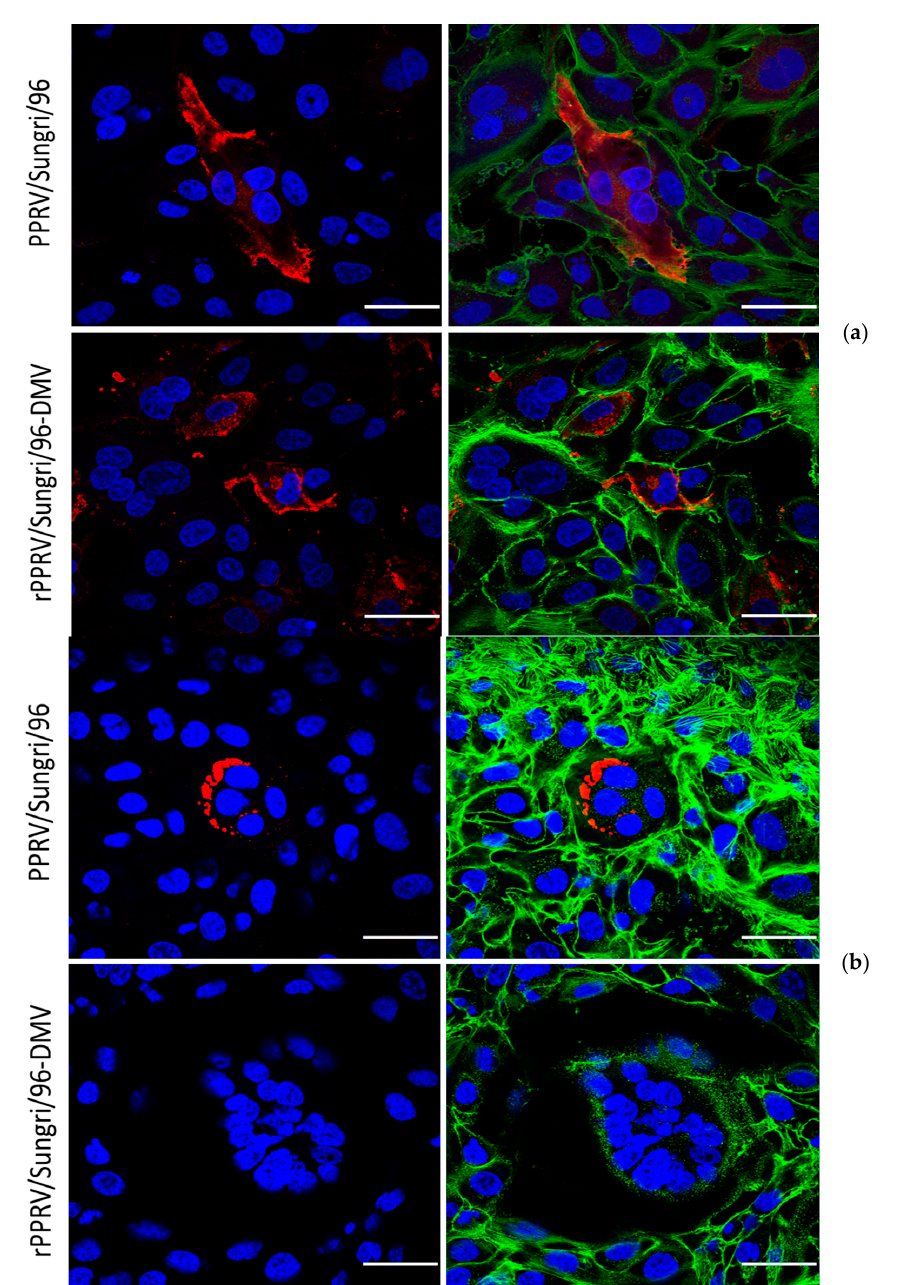
Figure 3. ( a ) Expression of the H-protein in cells infected with the parental PPRV/Sungri/96 and rescued rPPRV/Sungri/96-DMV viruses. A similar pattern was observed in PPRV/Nigeria/75/1 and rescued rPPRV/Nigeria/75/1-DMV virus infected cells. ( b ) Expression of the N-protein in cells infected with the parental PPRV/Sungri/96 and rescued rPPRV/Sungri/96-DMV viruses. A similar pattern was observed in PPRV/Nigeria/75/1 and rescued rPPRV/Nigeria/75/1-DMV virus infected cells. The scale bar represents 25 µ